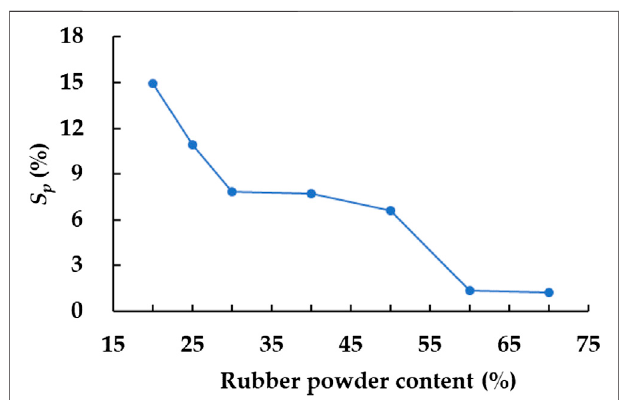
FIGURE 6 | The change of segregation percentage with